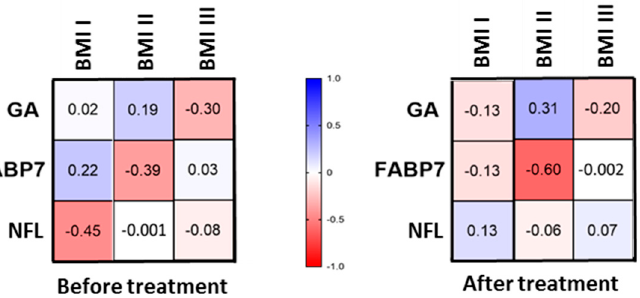
Figure 2. Division of patients before and after the treatment and into three subgroups according to BMI and correlations with FABP-7, GA and NFL concentrations.